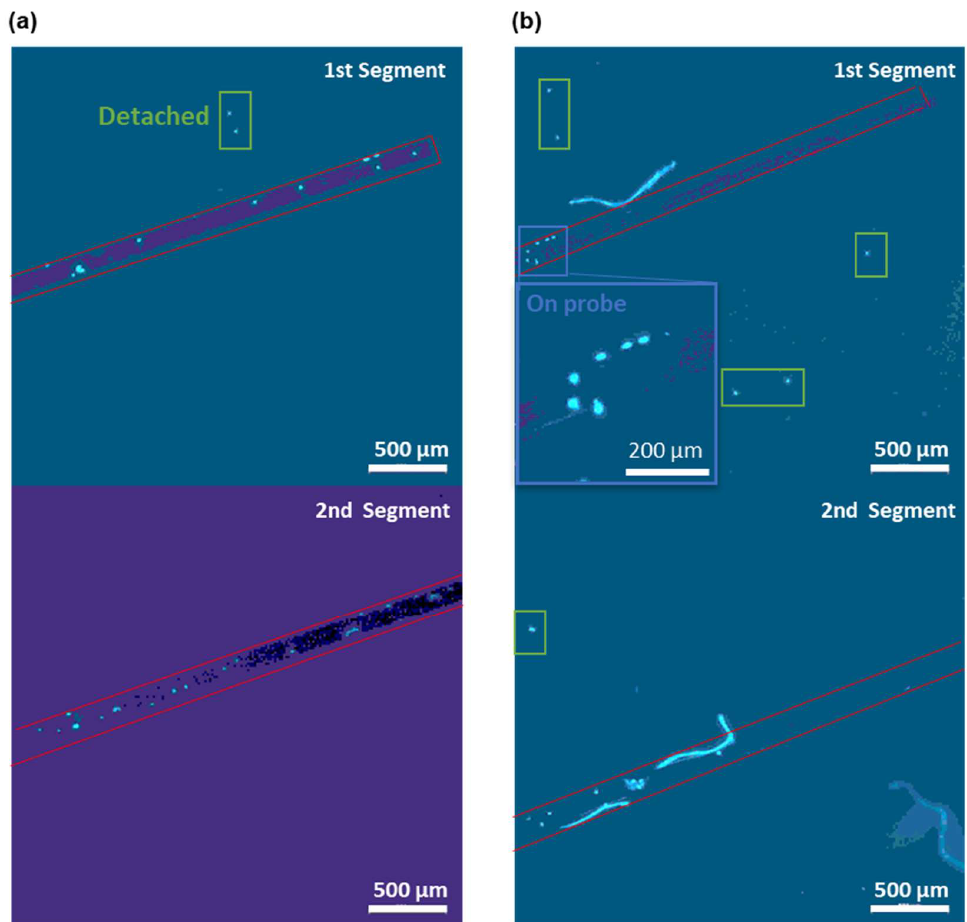
Figure 6. Micrographs of DAPI-stained MCF-7 cells (in bright blue color) on the fiber probes after the 15 min enrichment in PBS flows with a concentration of ( a ) 500 and ( b ) 10 MCF-7 cells/μL. Two 2.5 mm segments of the 5 mm long sensing region of the fiber probe were imaged separately with the 1st segment close to the fiber end and the 2nd segment close to the MMF. The red boxes outline the fiber probes in each micrograph. Insets show the zoomed in view of the cells attached on the probe surface (blue boxes). The detached cells are marked by green boxes.